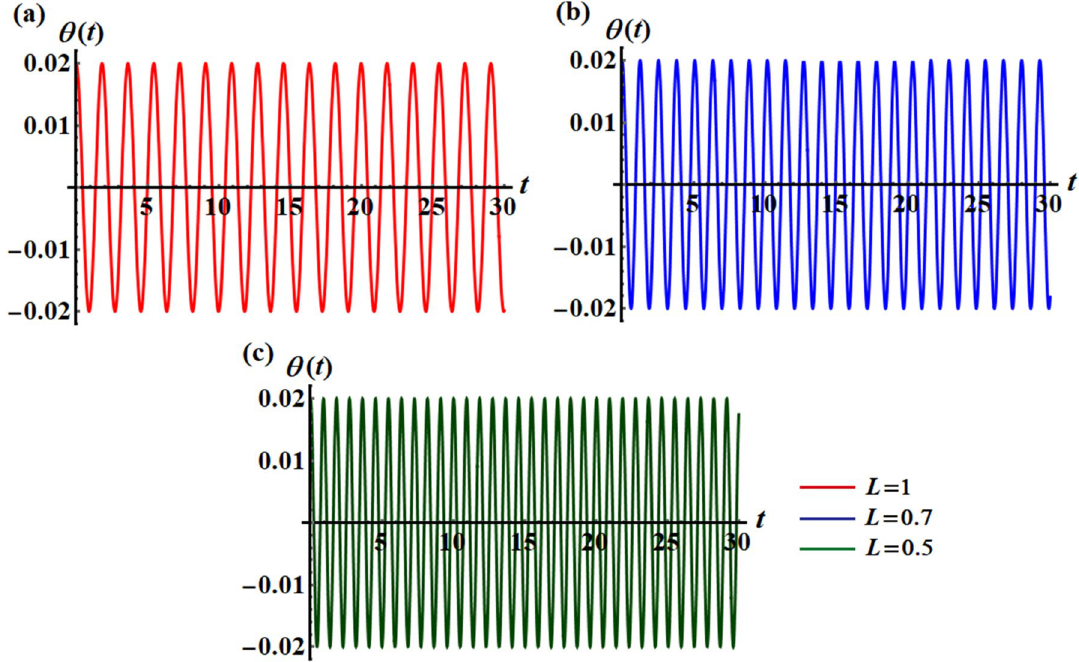
Figure 8. Describes the temporaly history of θ when τ = 0.0 at: ( a ) L = 0.5, σ = 2.78 , ( b ) L = 0.7, σ = 4.01 ( c ) L = 1.0, σ = 5.63